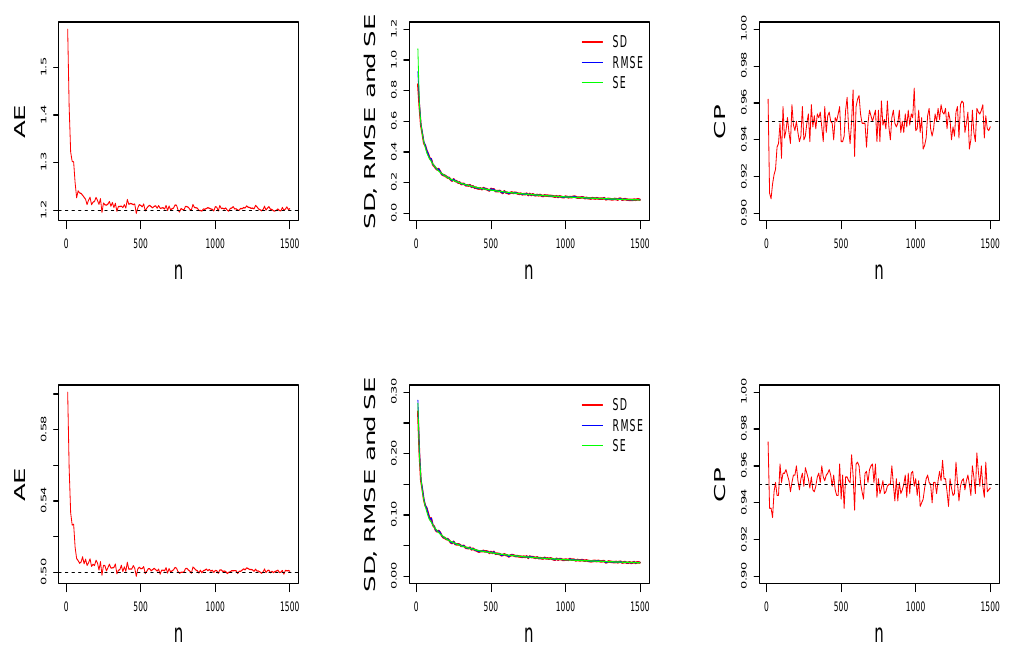
Figure 5. The AE, SD, RMSE, SE, and CP for each of the 1000 estimates of α ( top ) and β ( bottom ) obtained in scenario B, under the different sample sizes.